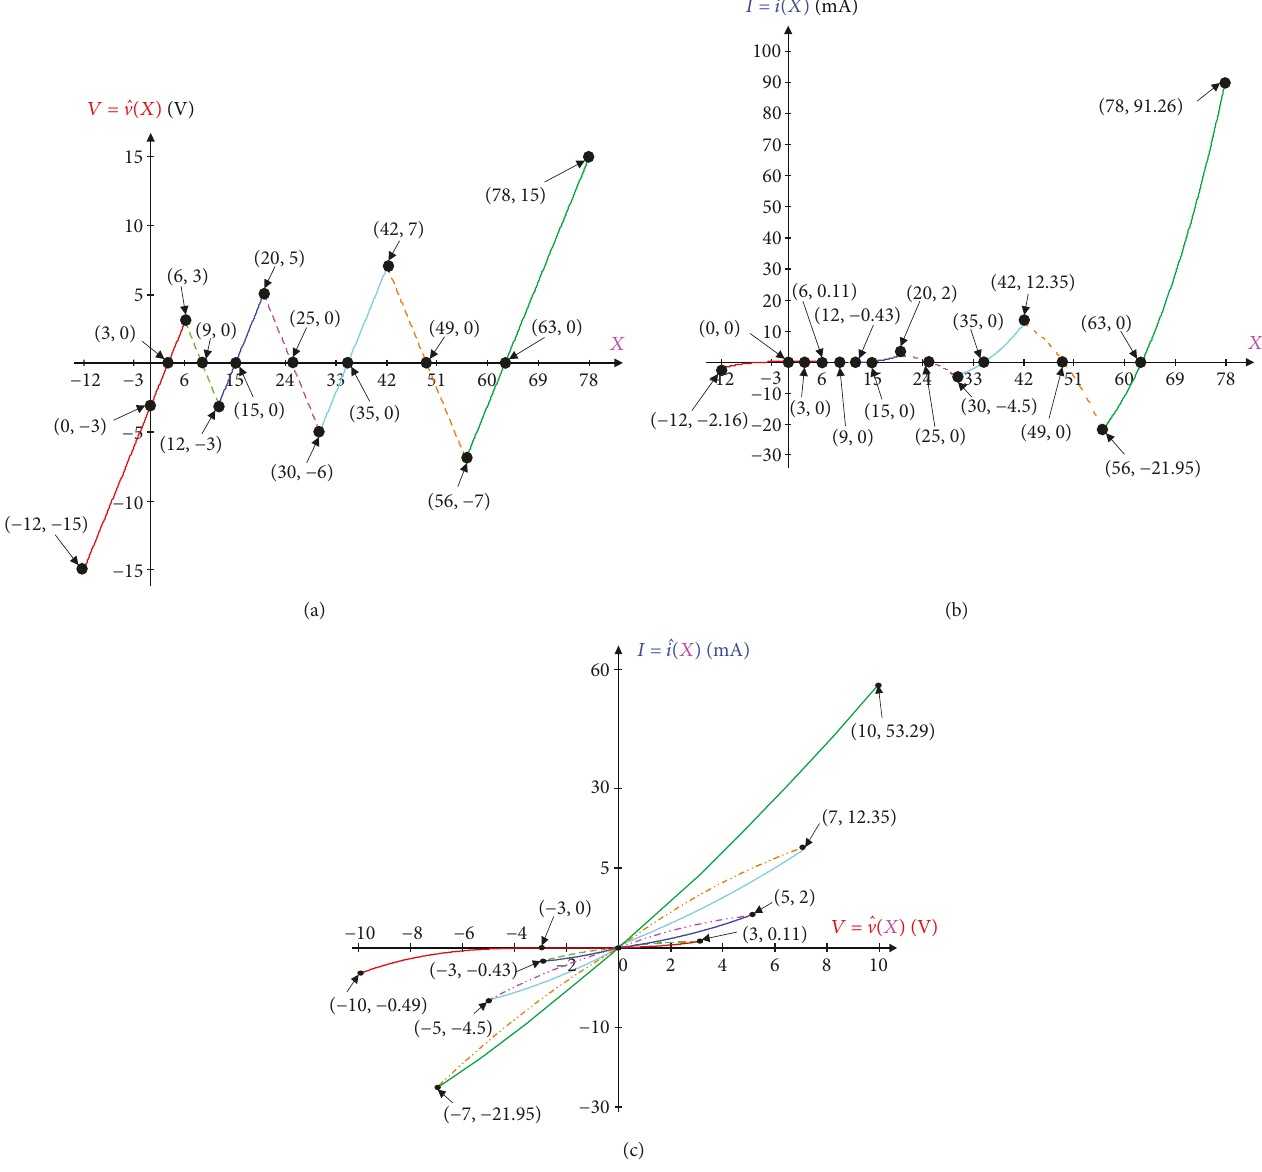
Figure 4: Parametric representations of the 6-lobe Chua corsage memristor (a) voltage V = ̂ v X versus state variable X and (b) current ̂ I = i X versus state variable X , for each value of χ = X : − 12 ≤ X ≤ 78 . (c) DC V - I plot, where the coordinates ( V , I ) of each point are extracted from (a) and (b), for each value of χ = X : − 7 ≤ X ≤ 73 for better